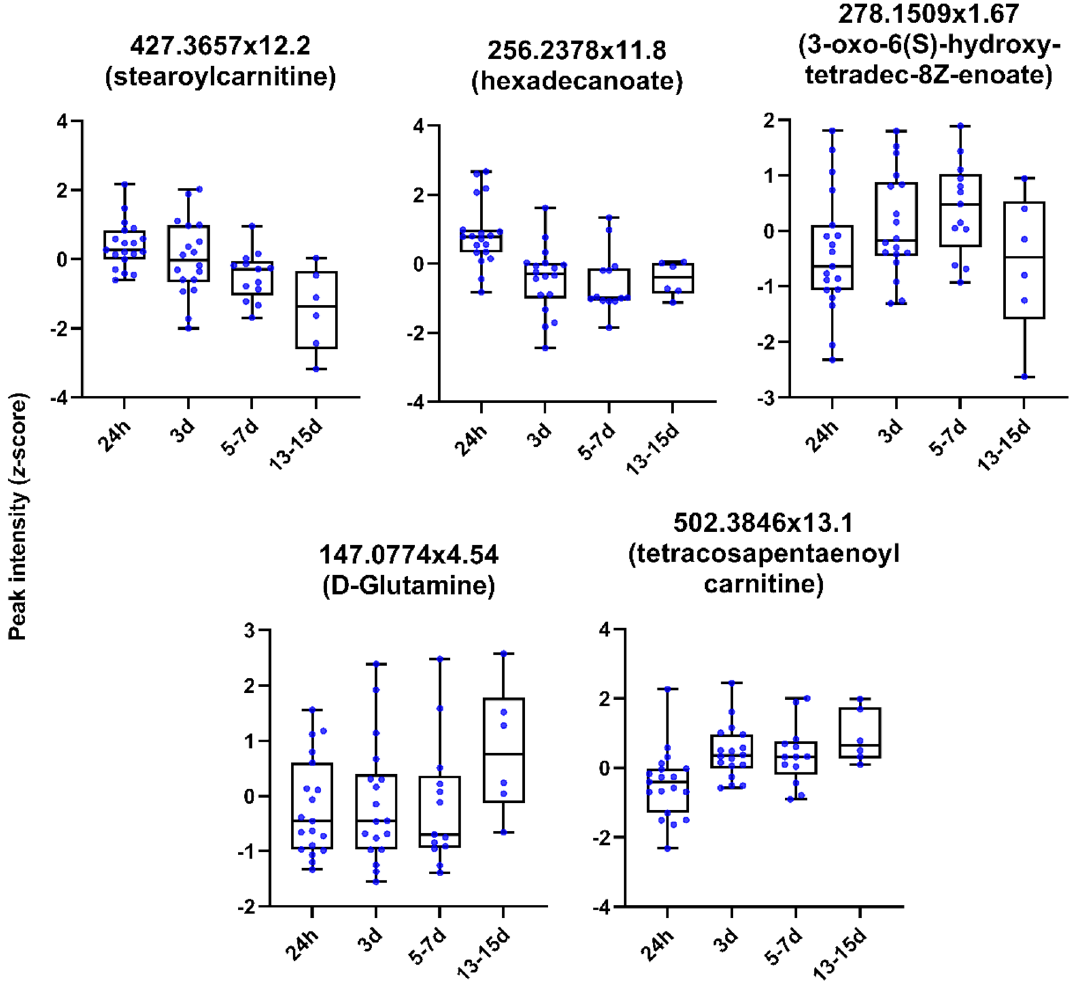
Figure 4. Boxplots (with median line, and whiskers of mininum and maximum value) for selected plasma metabolites showing change in intensity over time following stroke